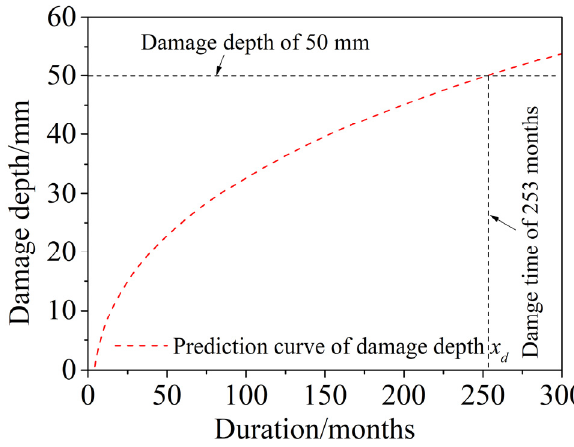
Figure 13. Prediction of time-dependent damage depth x d .